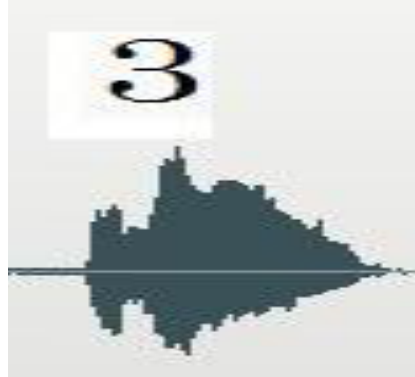
Fig. 4: Typical segment for word